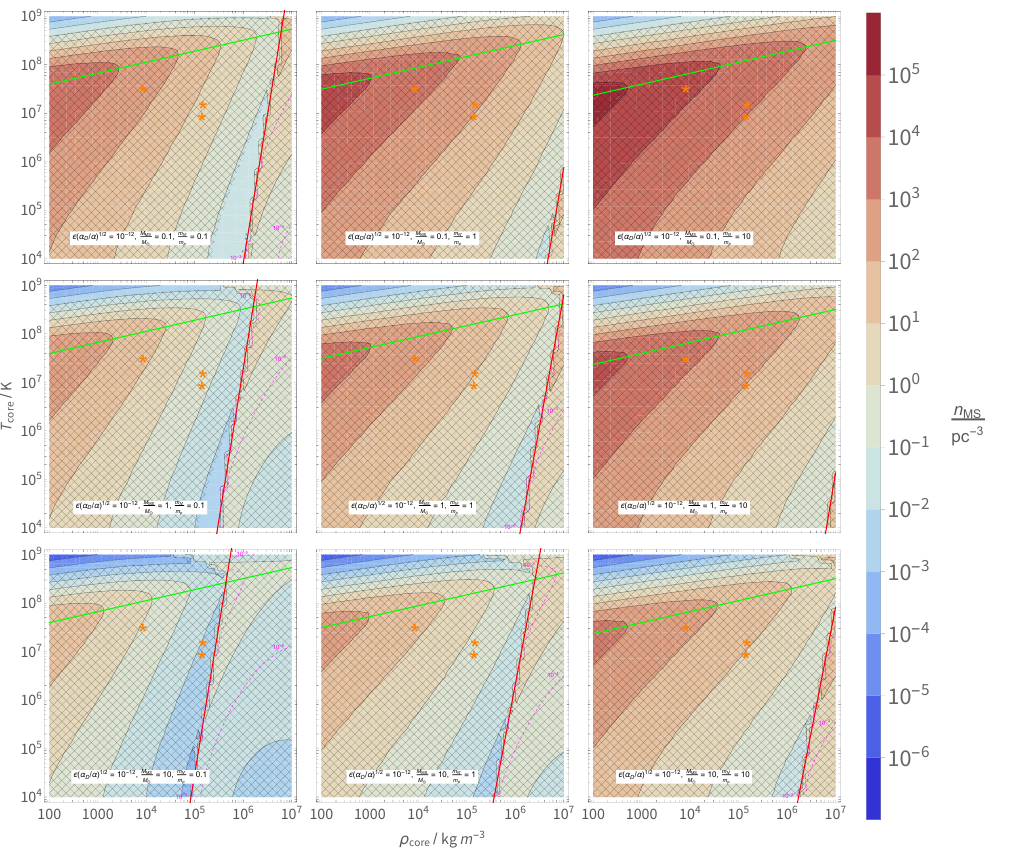
p α D /α em = 10 − 12